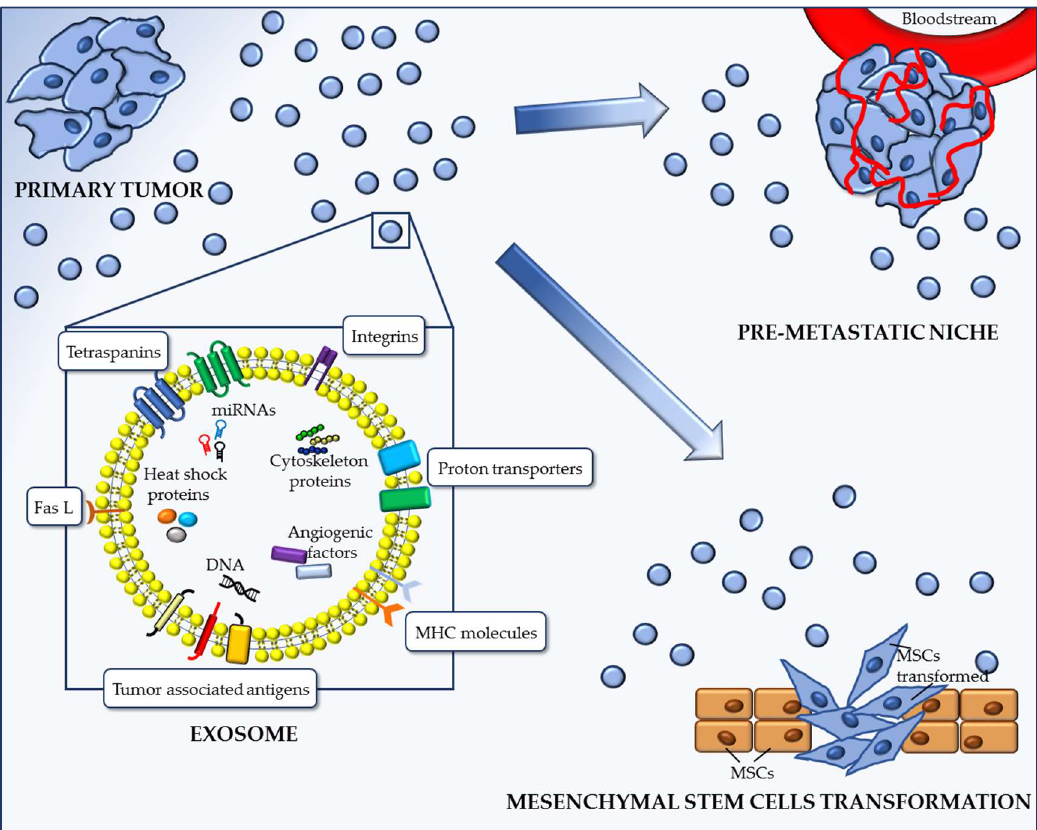
Figure 1. Role of exosomes in tumor dissemination and metastasis. Tumor cells release high levels of exosomes, delivering molecules with a pathogenetic role in metastatic spreading. The figure shows the involvement of exosomes in both pre-metastatic niche formation and mesenchymal stem cells’ (MSC) transformation.